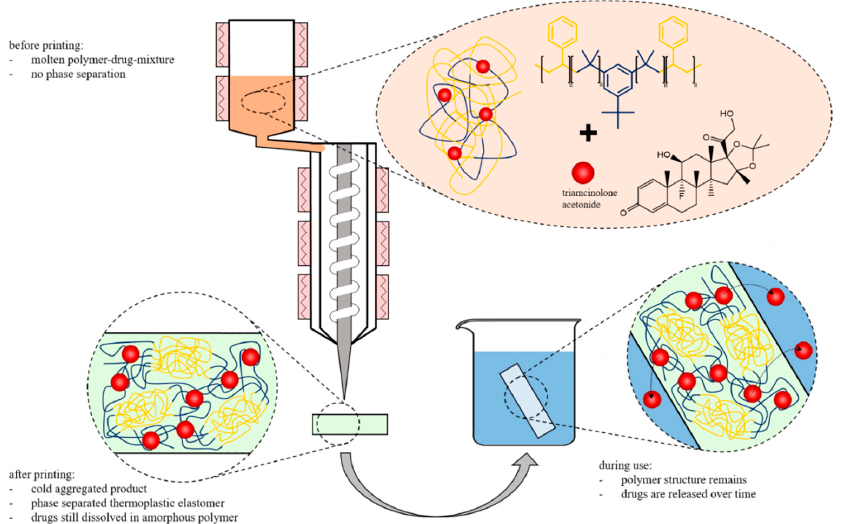
Figure 1. Concept of the 3D printing of triamcinolone acetonide (TA, red) embedded into SIBS triblock copolymers (S = yellow, IB = blue).